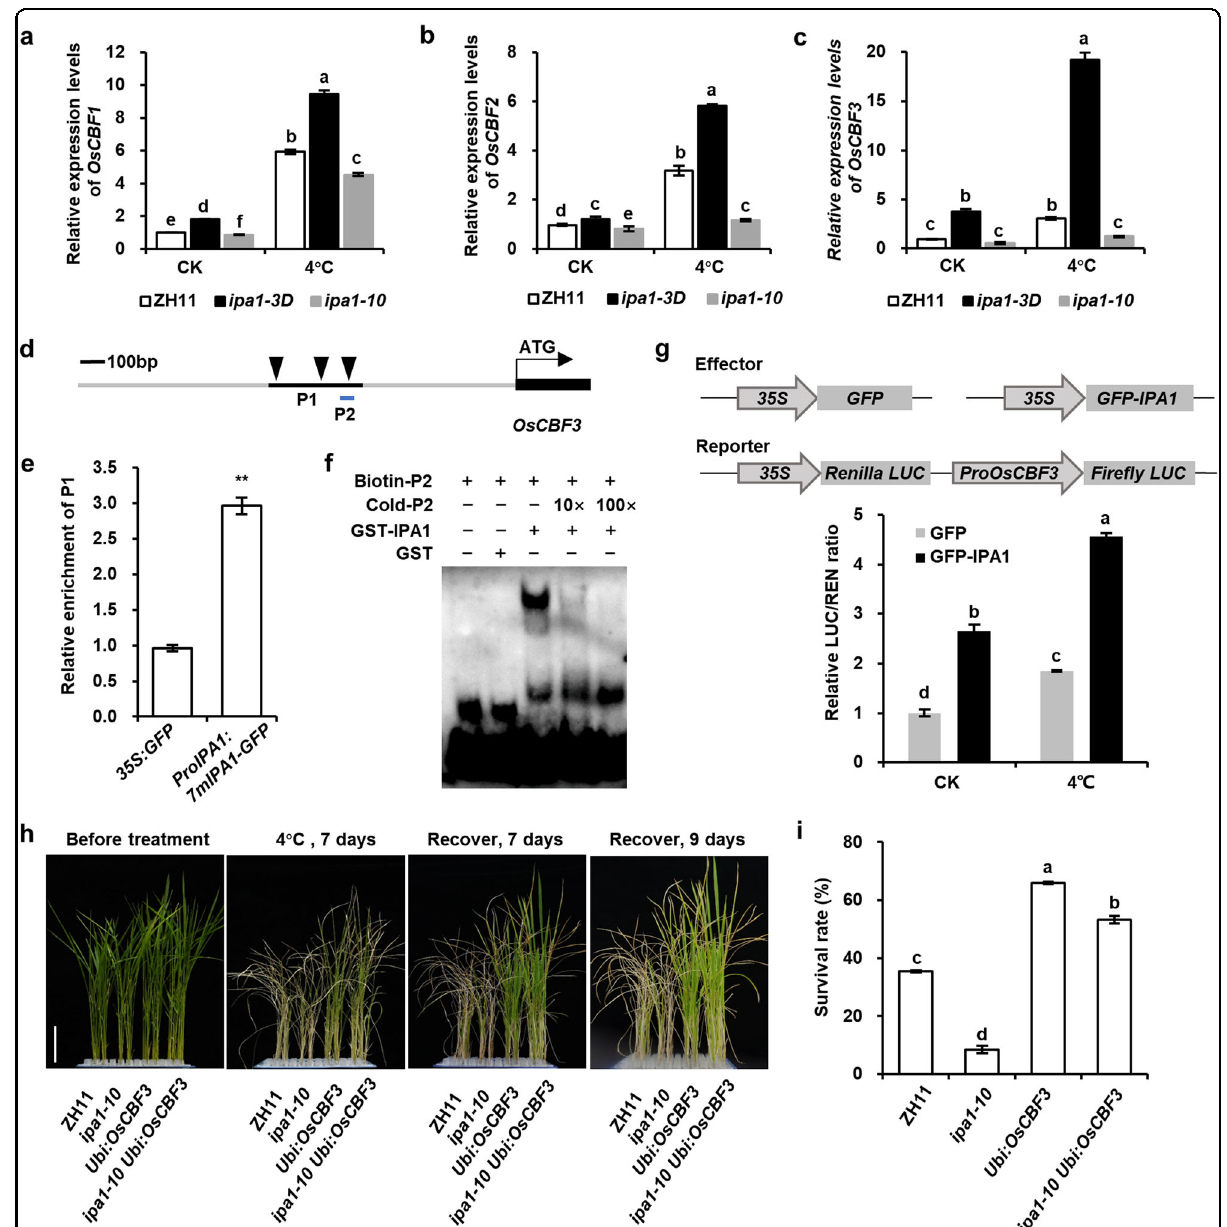
Fig. 6 IPA1 directly binds to and activates OsCBF3 promoter to regulate chilling stress response. a – c Expression levels of OsCBF1 ( a ), OsCBF2 ( b ), and OsCBF3 ( c ) in ZH11, ipa1-3D , and ipa1-10 plants under 25 °C (CK) or 4 °C for 6 h. d Schematics showing the promoter structure of OsCBF3 . Solid arrowheads indicate GTAC motifs in the OsCBF3 promoter. Hatched box P1 represents the fragment ampli fi ed in the ChIP-qPCR assay, and P2 represents the 42-bp fragment for EMSA. e ChIP-qPCR analysis of IPA1 binding sites (P1 in d ) in the OsCBF3 promoter with ubiquitin as a control. f Direct binding of IPA1 to the OsCBF3 promoter in the EMSA assay. Biotin-labeled 42-bp fragment of the OsCBF3 promoter (P2 in d ) was incubated with GST or GST-IPA1 protein. g Transcriptional activity assay in rice protoplasts shows that IPA1 could activate the expression of OsCBF3 . ProOsCBF3: LUC was co-transformed with GFP or GFP-IPA1 effector for 12 h and then incubated at 28 °C (CK) or 4 °C for 1 h. h Plant morphologies of 2-week-old ZH11, ipa1-10 , Ubi:OsCBF3 , and ipa1-10 Ubi:OsCBF3 seedlings before treatment, after 4 °C treatment for 7 days, and subsequent recovery for 7 or 9 days. i Survival rates of ZH11, ipa1-10 , Ubi:OsCBF3 , and ipa1-10 Ubi:OsCBF3 after 4 °C treatment as shown in h . In a – c , g and i , values are means ± SD ( n = 3 biological replicates). Different letters indicate signi fi cant differences ( P < 0.01) according to Tukey ’ s HSD test. In e , values are means ± SD ( n = 3 technical replicates). At least three independent experiments were performed with similar results, the asterisks indicate signi fi cant differences compared with the control (** P < 0.01, Student ’ s t -test). Bars = 5 cm in h . See also Supplementary Figs. S7 – S10 and Table